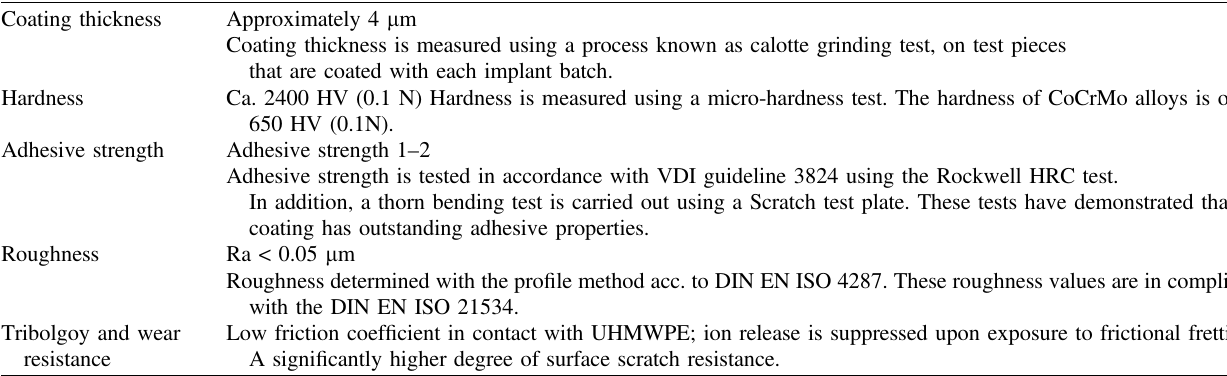
Table 3. TiN coating characteristics. Coating